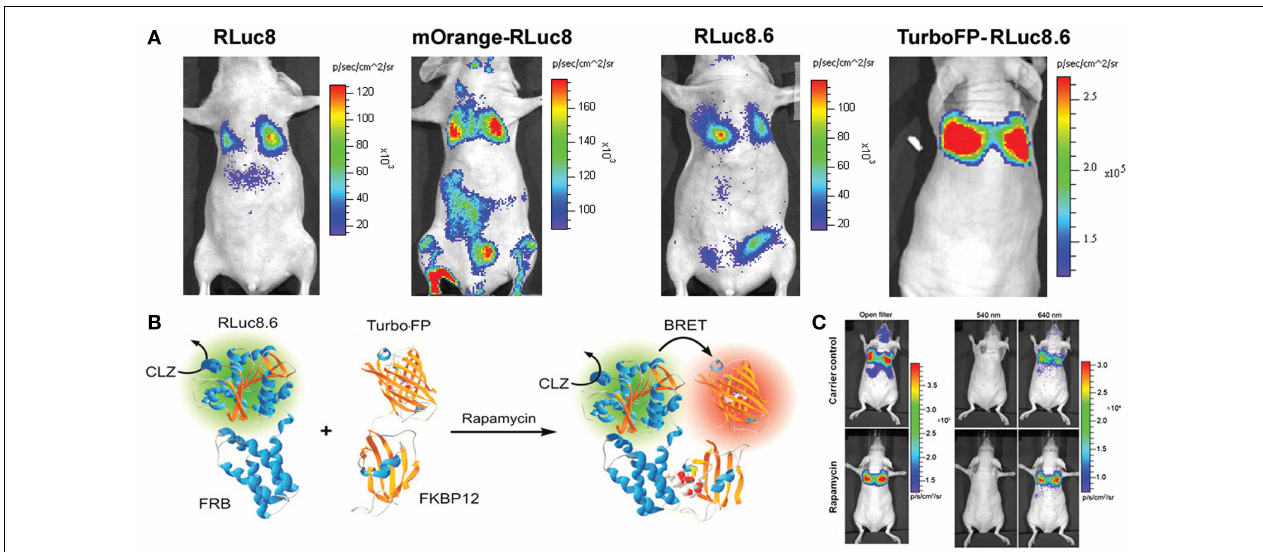
mammalian cells in the lungs which stably over-express FRB and FKBP12 interacting partners fused to RLuc8.6 andTurboFP respectively. Cells (3 × 10 6 in 150 µ L PBS) were injected through the tail vein, resulting in significant trapping in the lungs. One group of mice ( n = 8) was injected 2h before cell injection with 40 µ g rapamycin dissolved in 20 µ L DMSO and further diluted in 130 µ L PBS administered through the tail vein. A second group of mice ( n = 8) was injected with DMSO (20 in 130 µ L PBS).Two hours after cell injection, the mice were injected i.v. with Clz substrate and sequentially imaged using open/donor/acceptor filters. Substrate-only control mice ( n = 4) were used for background subtraction.The figure is partially represented with permission from PNAS